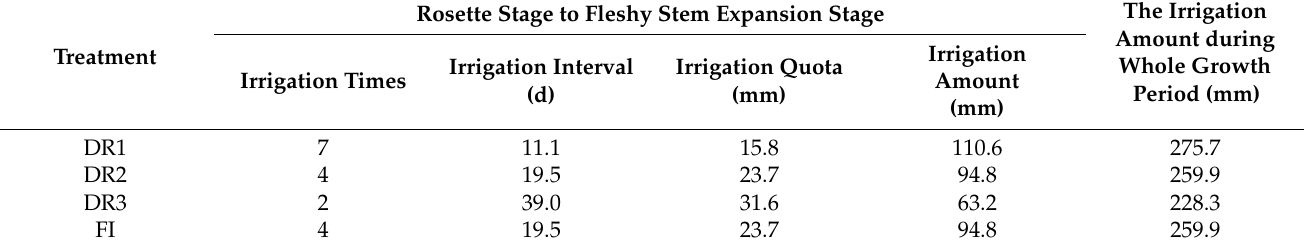
Table 1. The irrigation regime.